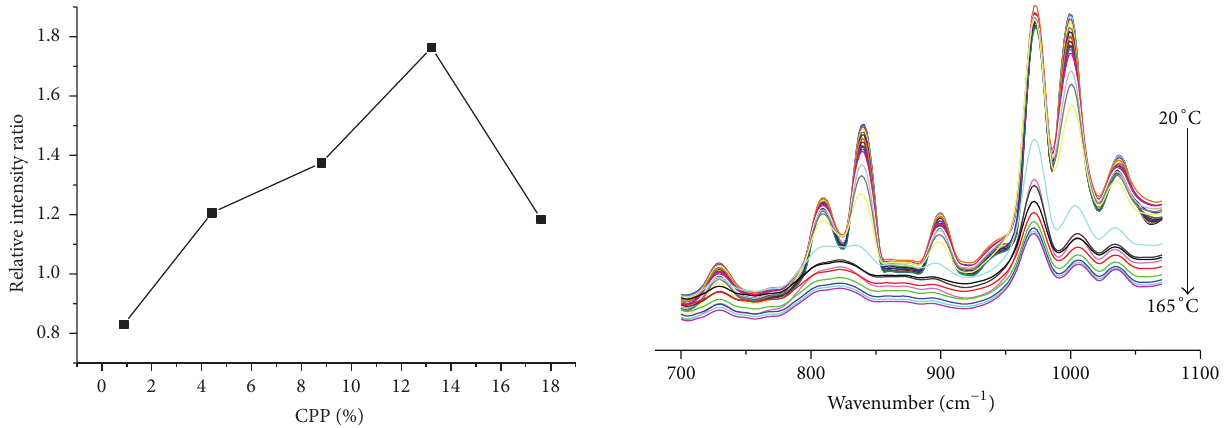
Figure 8: FTIR spectra of PP/PANI 4 at different temperatures.